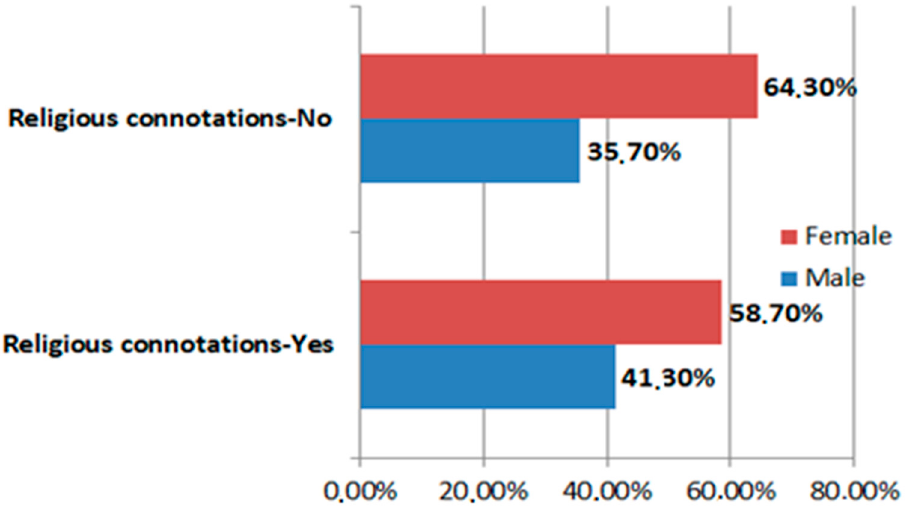
Figure 5. Religious connotations in terms of gender for the name Gloria in the metropolitan district of Murcia.